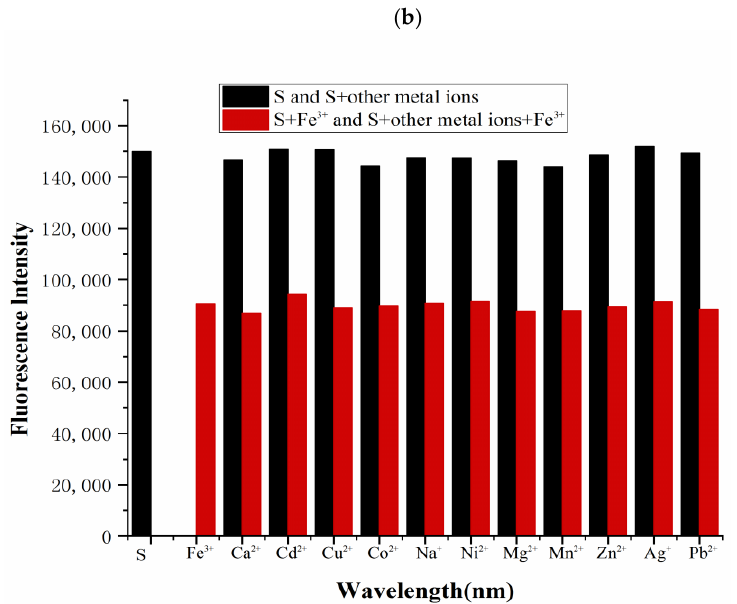
Figure 5. ( a ) The fluorescence responses of probe S (20.0 µ M) toward different metal ions (10.0 mM). ( b ) The fluorescent response of probe S (20.0 µ M) upon the addition of Fe 3+ (10.0 mM) in the presence of an excess of various metal ions (10.0 mM) ( λ ex = 355 nm, slit: 10 nm/10 nm).